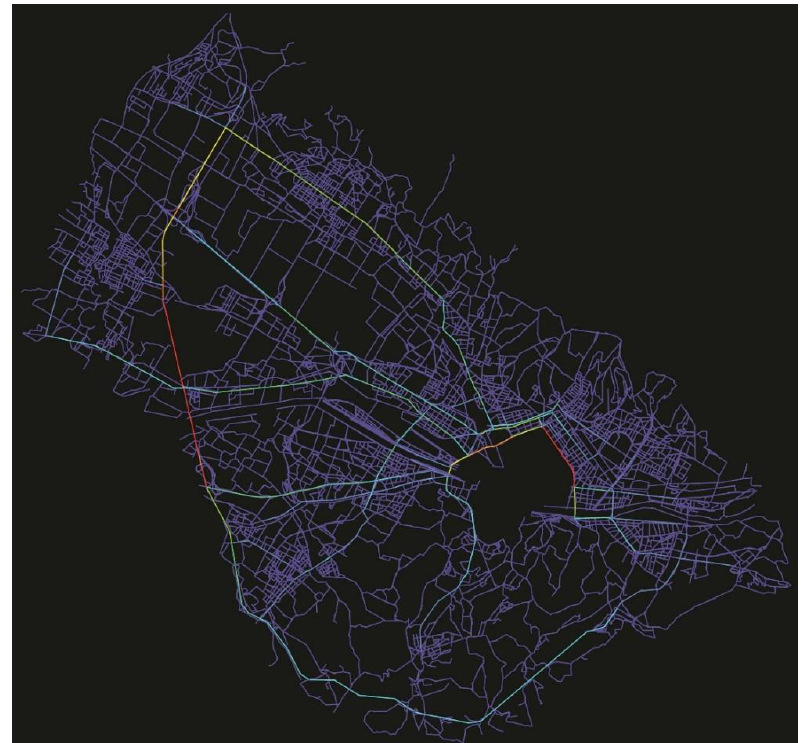
Figure 10. Distribution of choice value in Florence ( R = 15,000 m), net of the limited traffic zone.